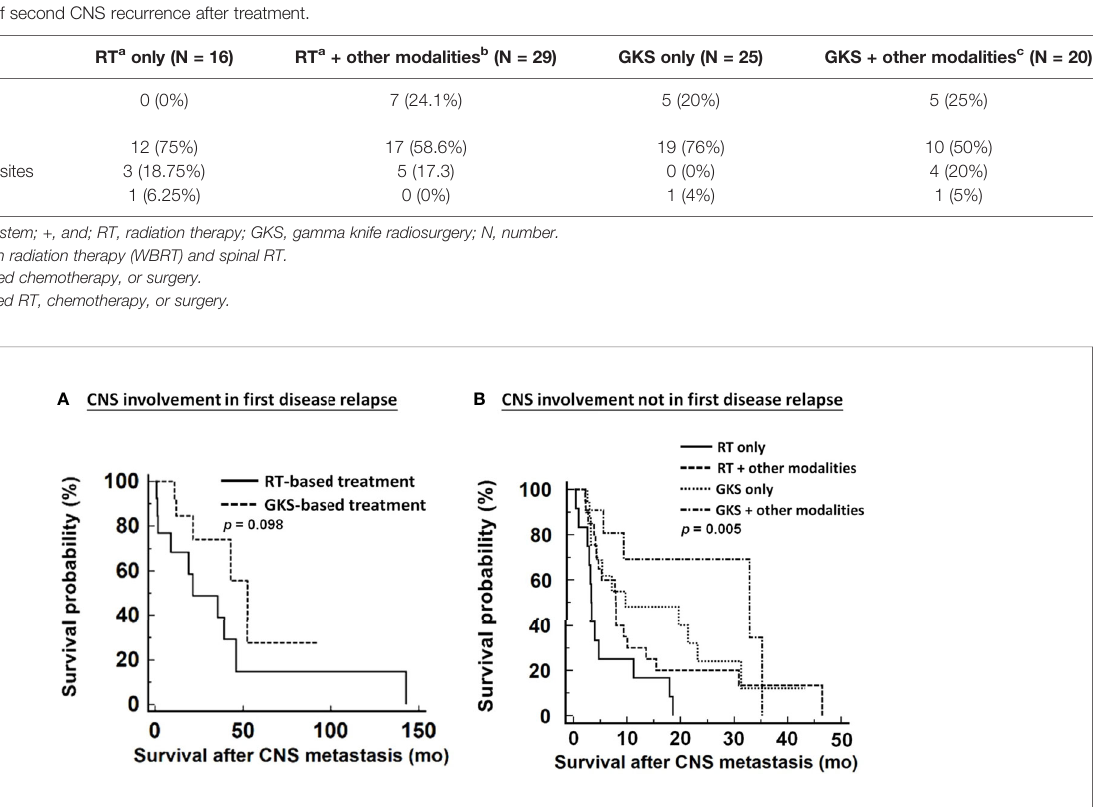
FIGURE 4 | Impacts of various therapeutic modalities on survival outcomes of patients from diagnosis of CNS metastases. (A) patients with CNS involvement in fi rst disease relapse, (B) patients with CNS involvement not in fi rst disease relapse. CNS, central nervous system; RT, radiation therapy; GKS, gamma knife radiosurgery. RT included WBRT and spinal